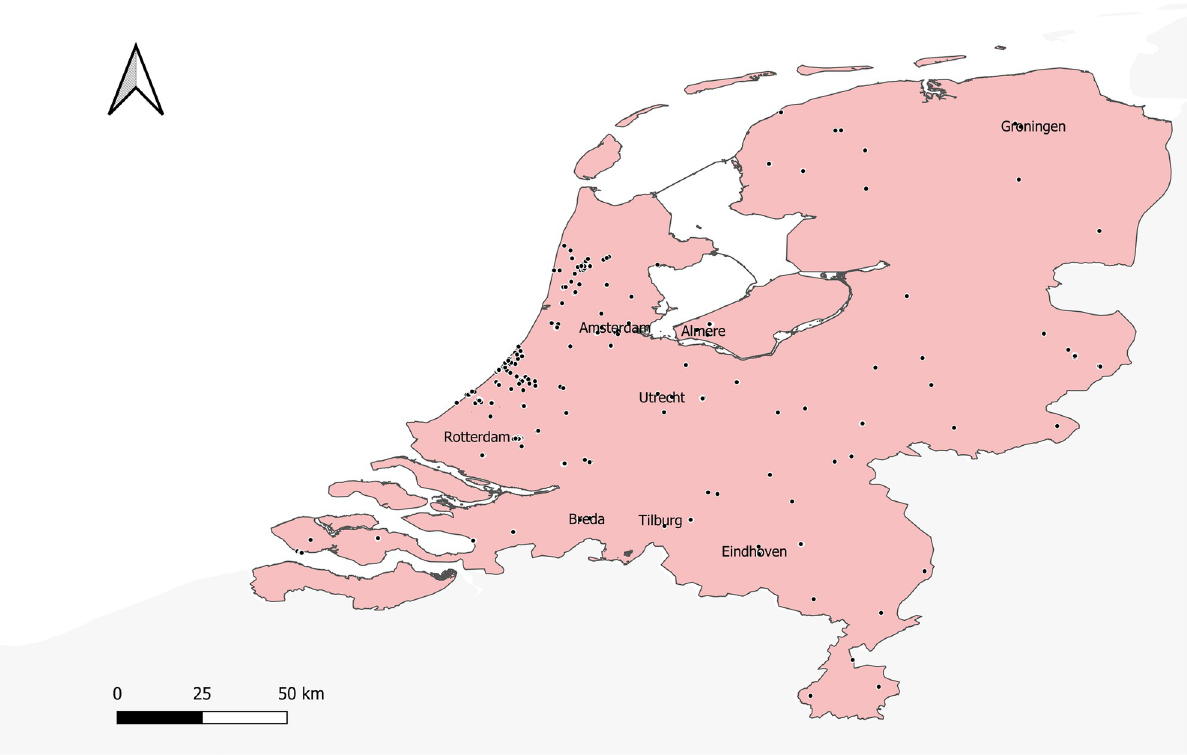
Fig 1. Spatial distribution of RMC sensors. The map is made with Natural Earth by the authors. The locations of footfall counters, denoted in dots, are provided by Bureau RMC.